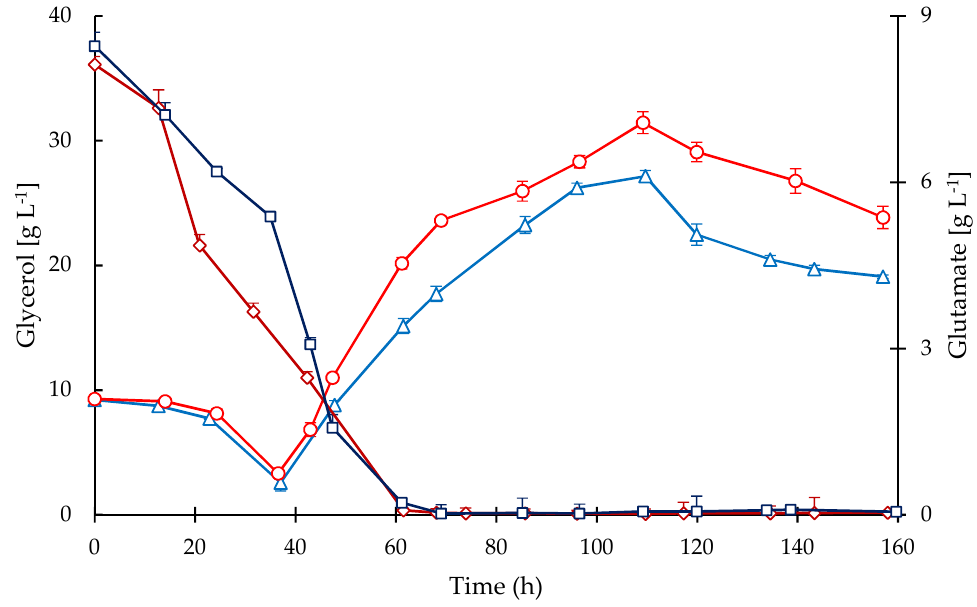
Figure 4. Time courses of substrates in the culture media for fed-batch cultivations of S. clavuligerus. Glycerol in STR (triangles) and CT (circles), glutamate in STR (squares) and CT (diamonds). A high concentration of glutamate was provided initially in the media but not in the